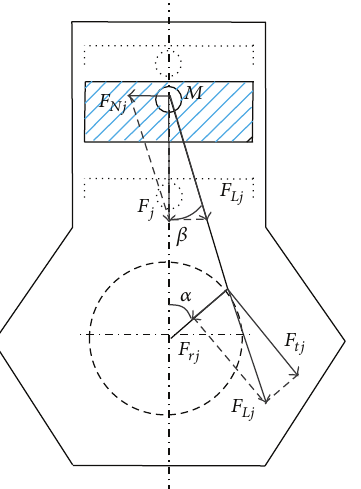
Figure 4: Some parameters for transient engine friction